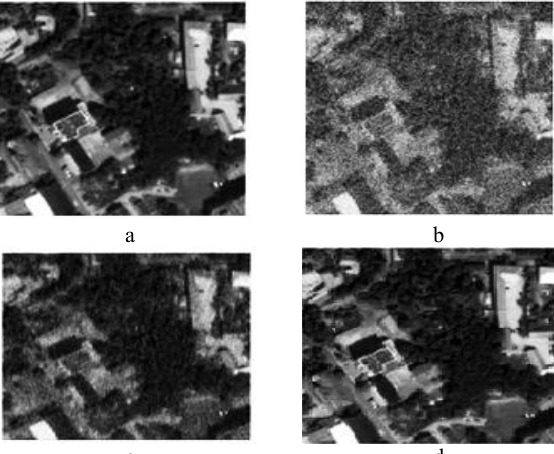
Figure 2. Filtering satellite images: source image (a), noisy image (b), one frame filtering (c), eight frame filtering (d).